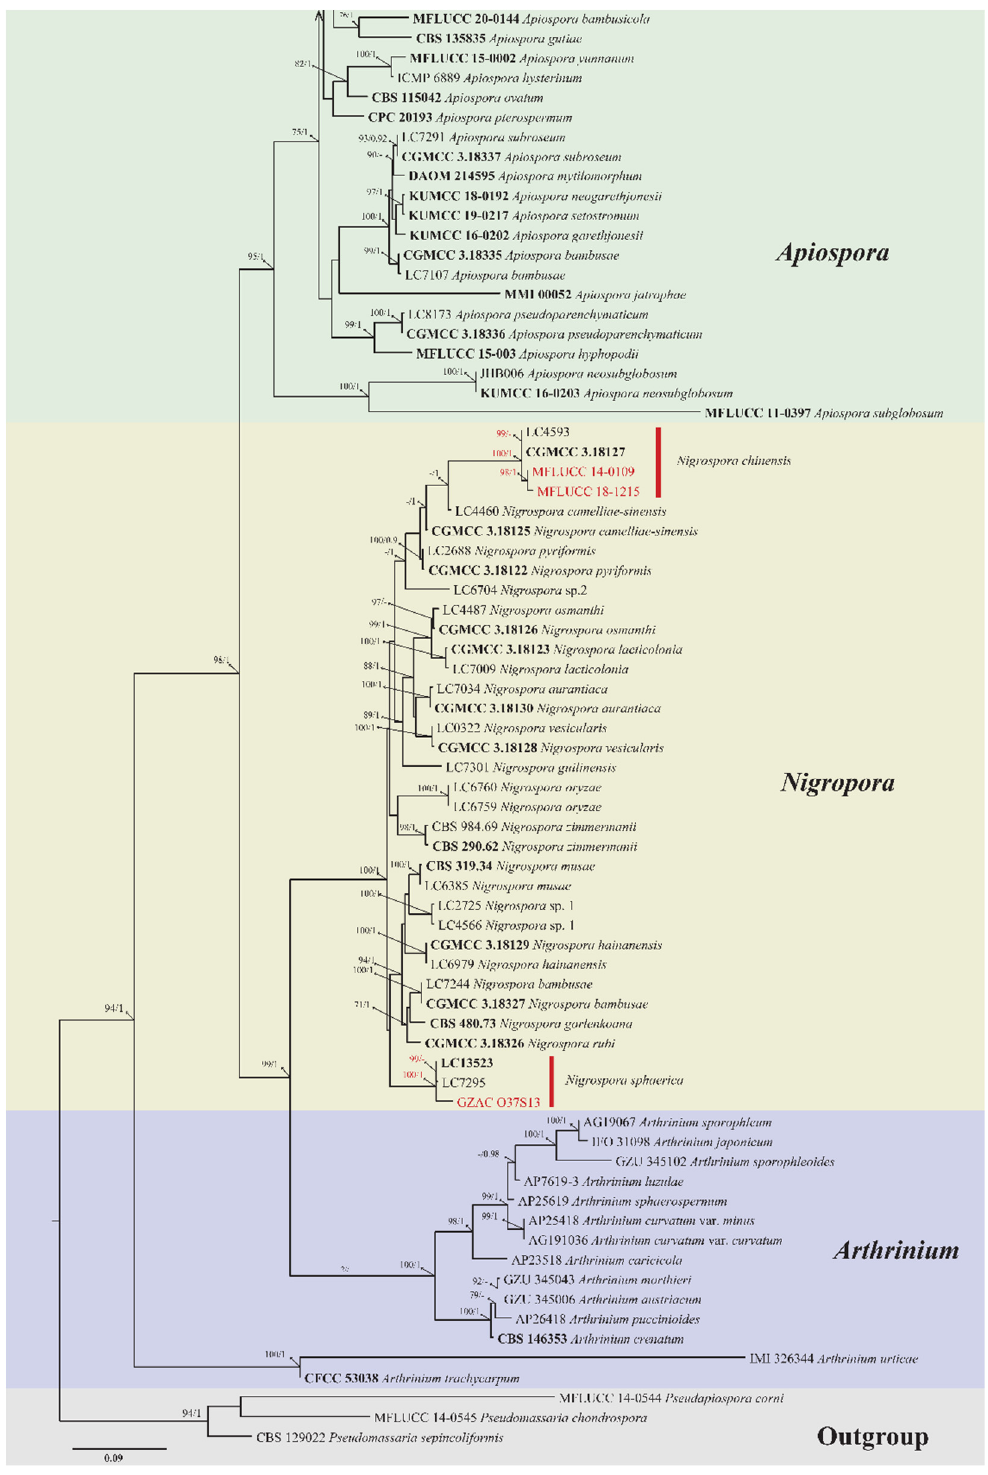
Figure 1. A multi-locus phylogenetic tree based on the combined ITS-LSU-TUB2-TEF-1 α sequences of Apiosporaceae species resulting from a maximum likelihood analysis. Pseudomassaria chondrospora (MFLUCC 14-0545), Pseudomassaria sepincoliformis (CBS 129022), and Pseudopiospora corni (MFLUCC 14-0544) are selected as outgroup. The isolates from this study are in red. The ex-type isolates are in bold. Maximum likelihood values (ML) equal or greater than 70 and/or 0.9 Bayesian posterior probabilities (BPP) are labelled at the end of nodes. Dashes are indicated values lower than 70% ML and/or 0.9BPP. Scale bar corresponds to 0.09 substitutions per site.